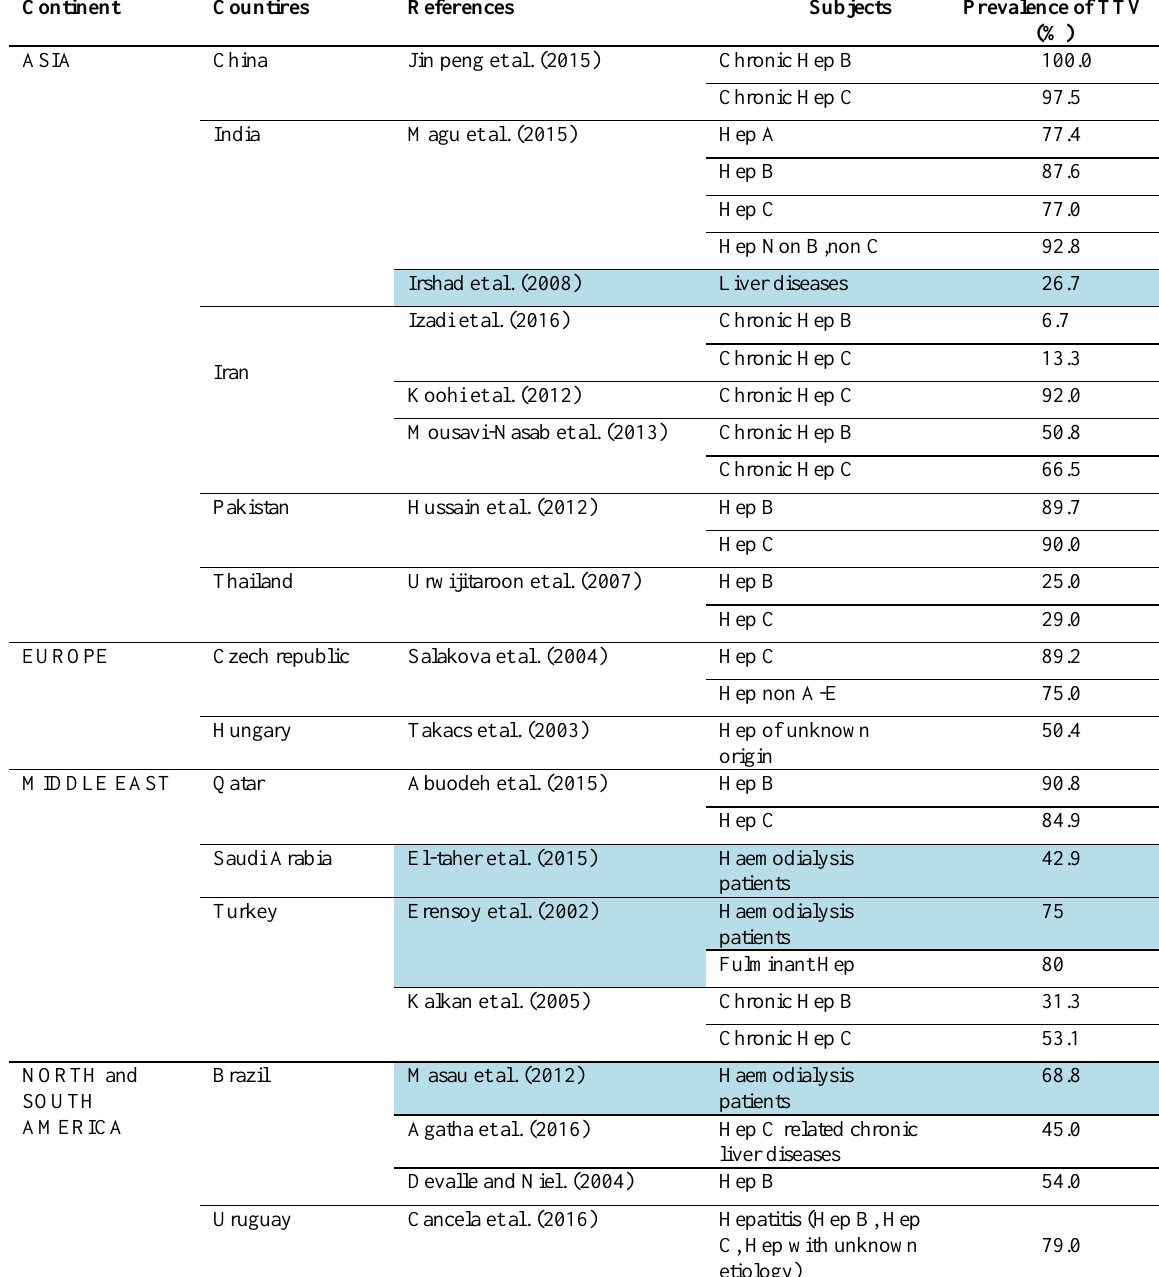
Table 2 : List of TTV prevalence among hepatitis and liver-related diseases patients. The blue-coloured tables are the prevalence among non-hepatitis patients but liver-related diseases patients (Jarkasi et al.,